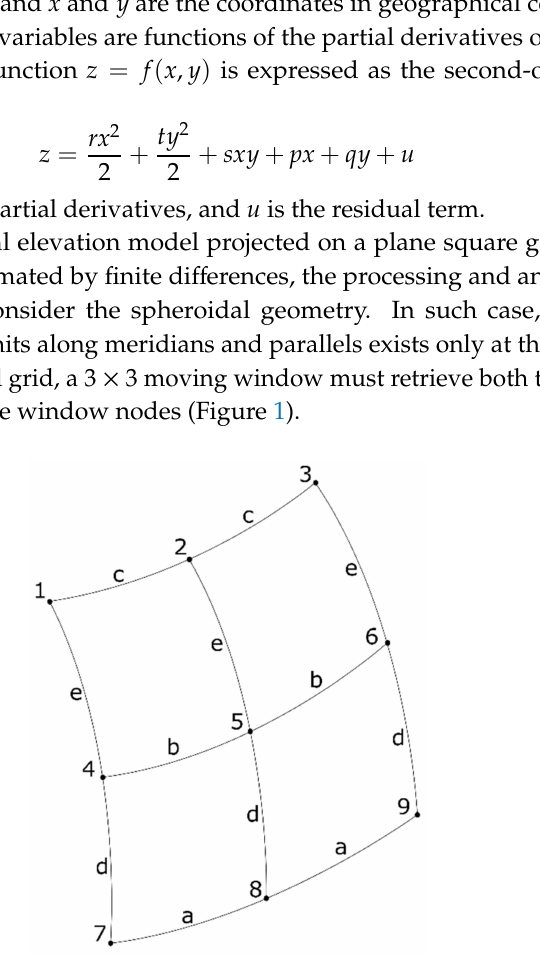
Figure 1. A 3 × 3 spheroidal equal angular grid with linear geometries a, b, c, d, and f, and nine elevation nodes—adapted from